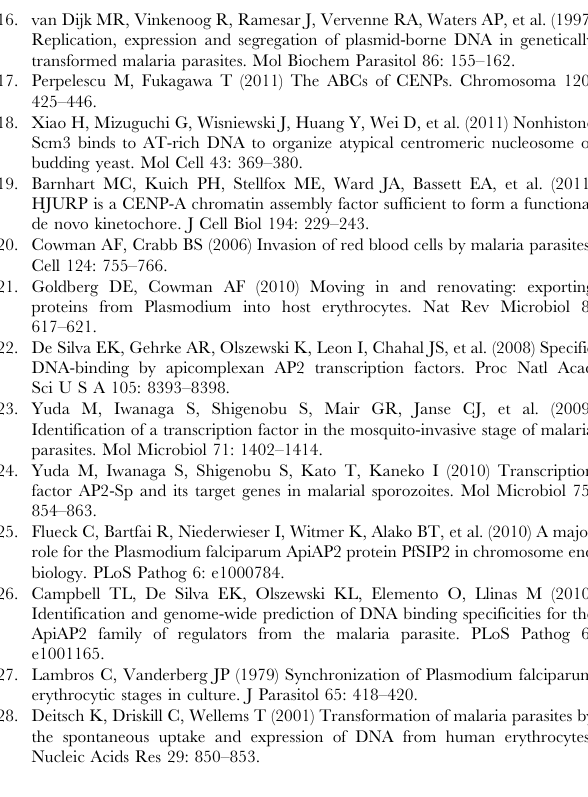
Figure S2 The growth of the parasites carrying pFCEN and pCon were monitored in the presence and absence of pyrimeth- amine. The open and closed circles indicate the parasitemia of the parasites carrying pFCEN and pCon, respectively. The blue and red lines show the conditions in the presence and the absence of the drug, respectively. Figure S3 (A) The pFCENv2 plasmid is 8477 bp, and pfcen5-1.5 is placed downstream of the 3 9 UTR of the hrp2 gene of P. falciparum . In this plasmid, blasticidin S deaminase is used as the drug-selectable marker. (B) The parasites carrying pFCENv2 (lanes a and b) were maintained in the presence of the drug for 2 months, and genomic DNA was purified. Southern analysis of pFCENv2 was performed using the gfp gene as a probe. The